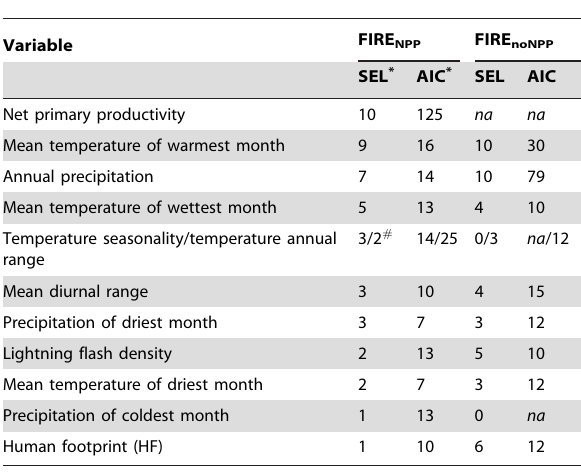
FIRE NPP and FIRE noNPP sub-models based on the number of times the explanatory variable was selected (SEL) and the mean change in AIC value, which was used to measure the relative amount of variation